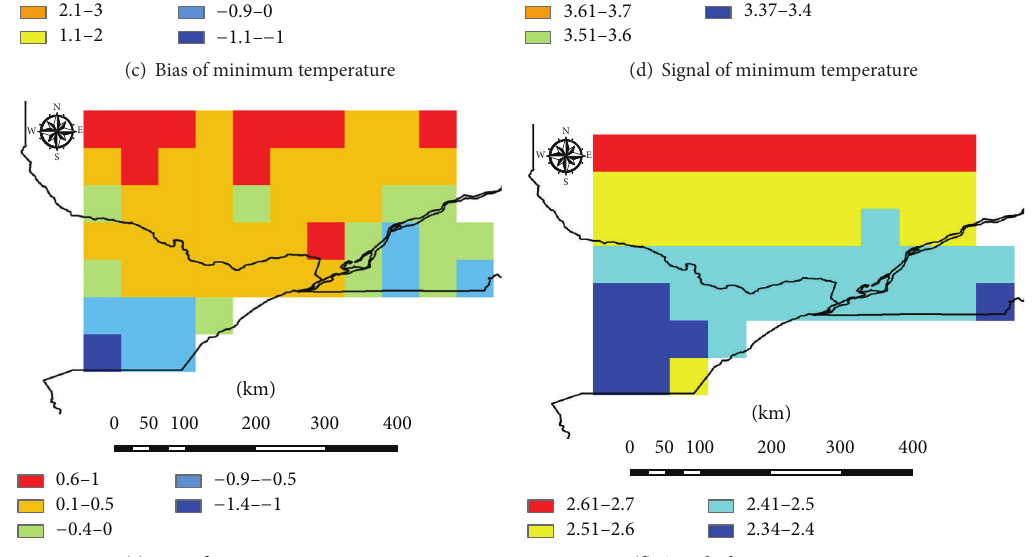
Figure 3: Same as Figure 2 but for the winter